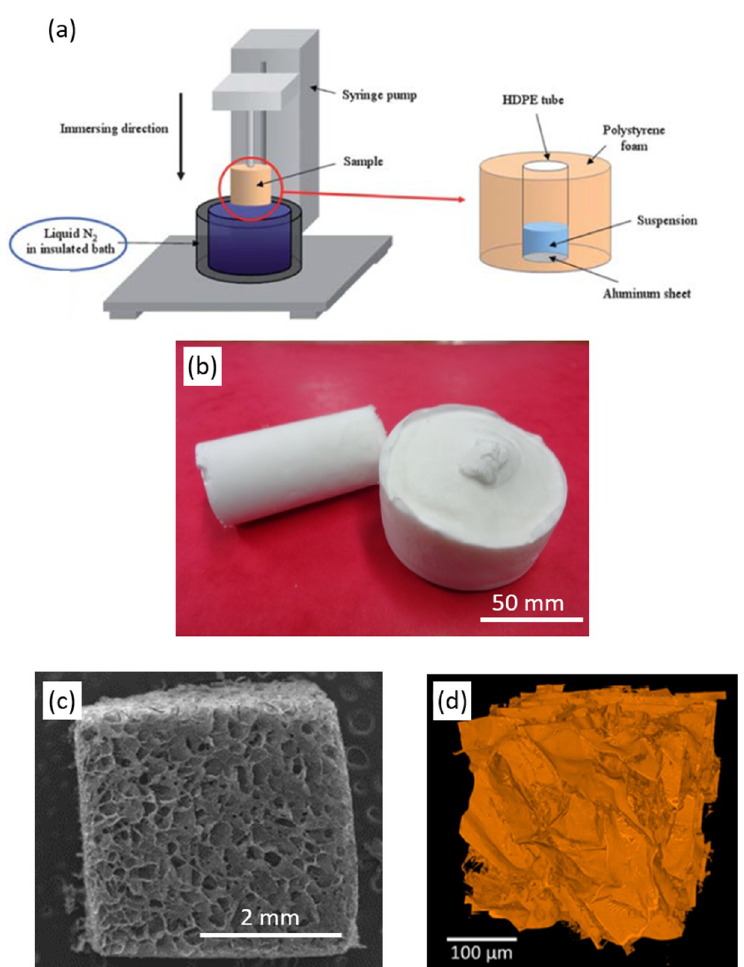
Figure 5. ( a ) Scheme of a freezing apparatus. The nanocellulose suspension is frozen by introducing the mould in a cold liquid. (Adapted from Lee et al. [118] with permission from the Royal Society of Chemistry). Photograph ( b ), Scanning Electron Microscopy (SEM) micrograph ( c ), and 3D tomographic image (voxel size: 0.32 3 µ m 3 ) ( d ) of TEMPO-oxidised CNF foam ( ρ ≈ 11 kg m − 3 ) prepared by